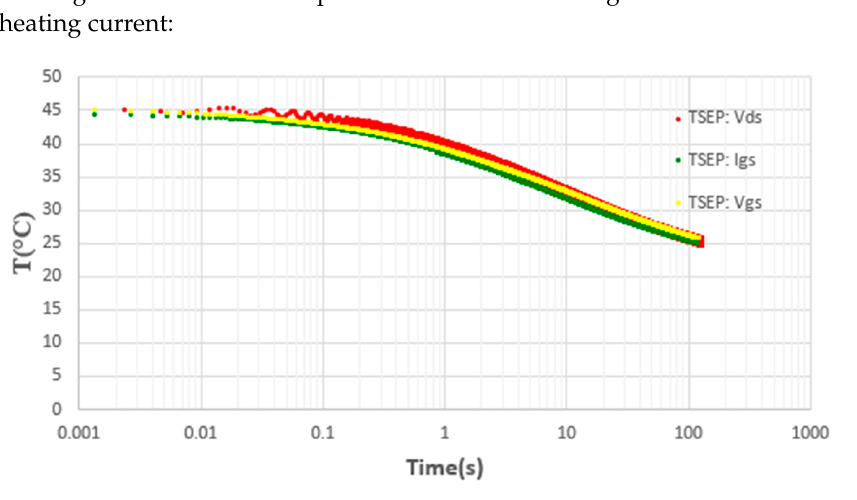
Figure 20. Comparison of cooling curves when the heating current is 3 A.